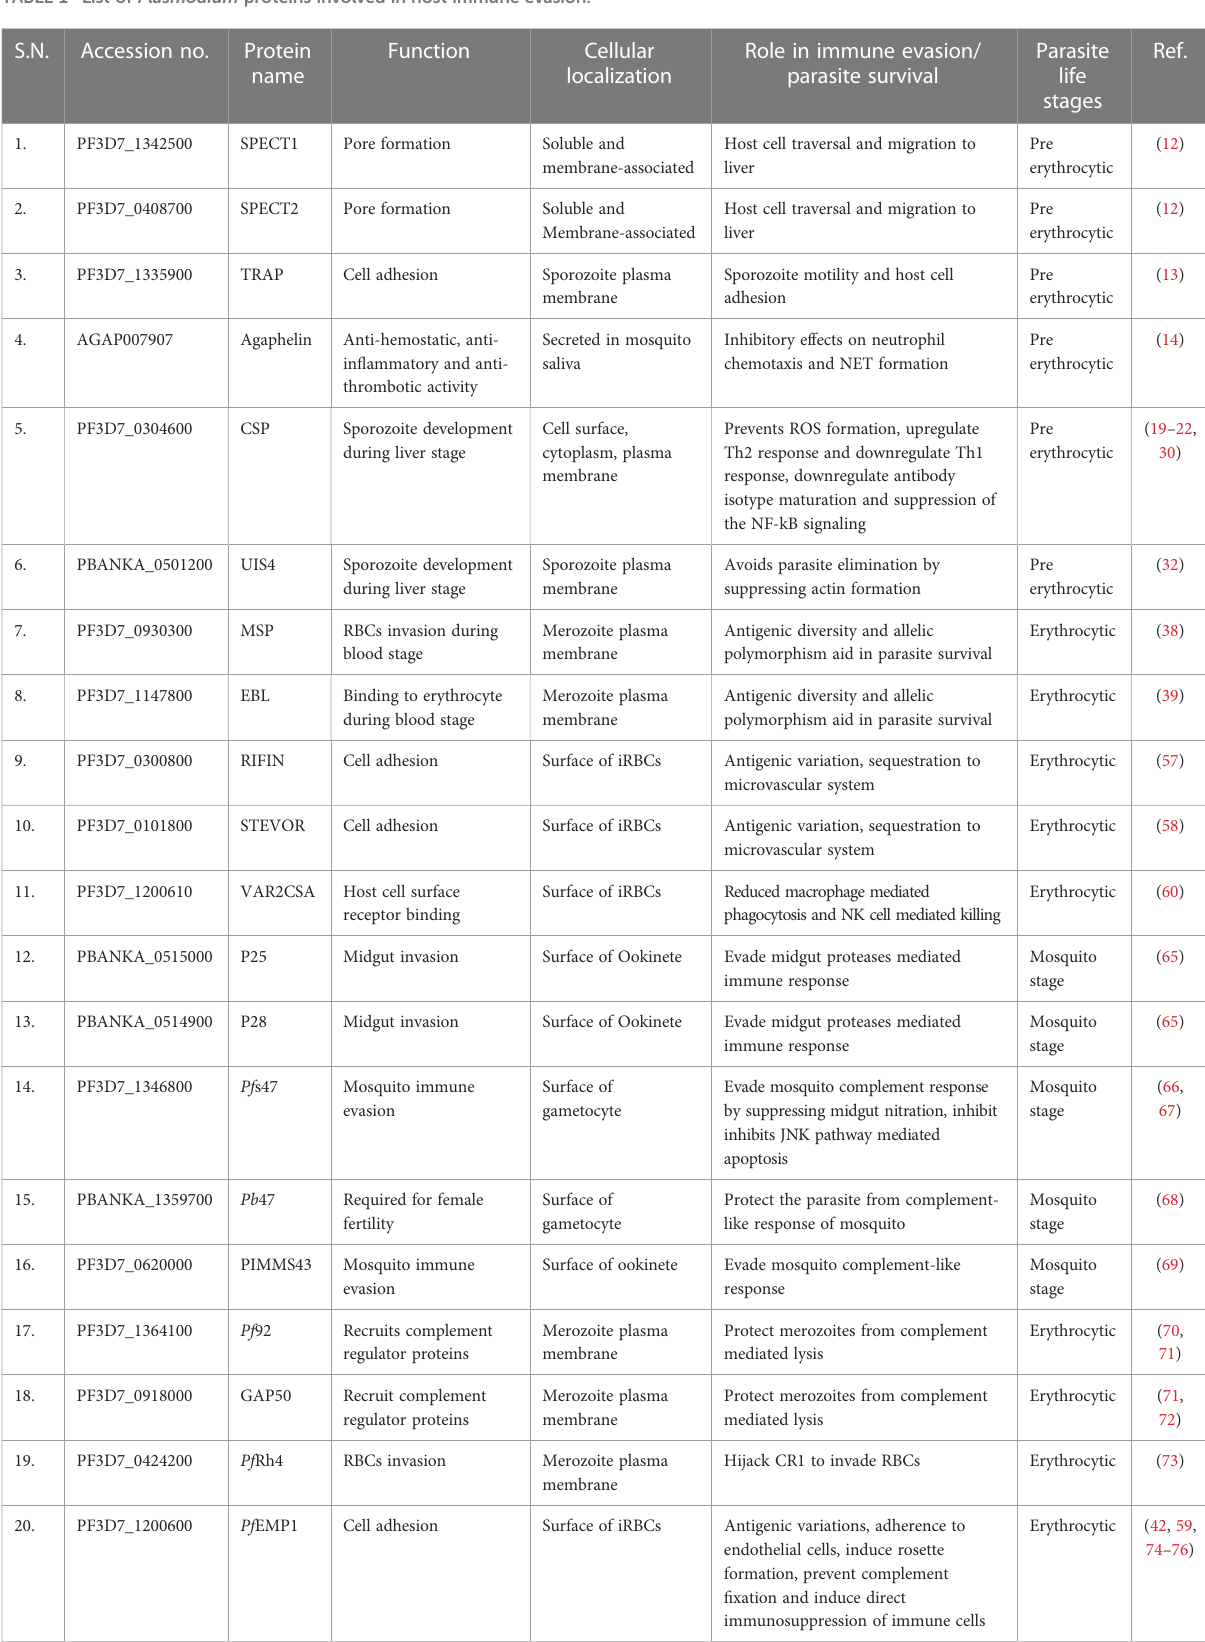
TABLE 1 List of Plasmodium proteins involved in host immune evasion.